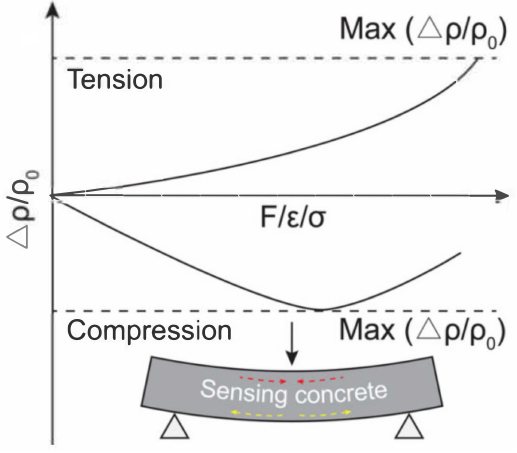
Figure 8. Self-sensing concrete under flexure. Reproduced with permission from [51], Journal of Applied Physics,